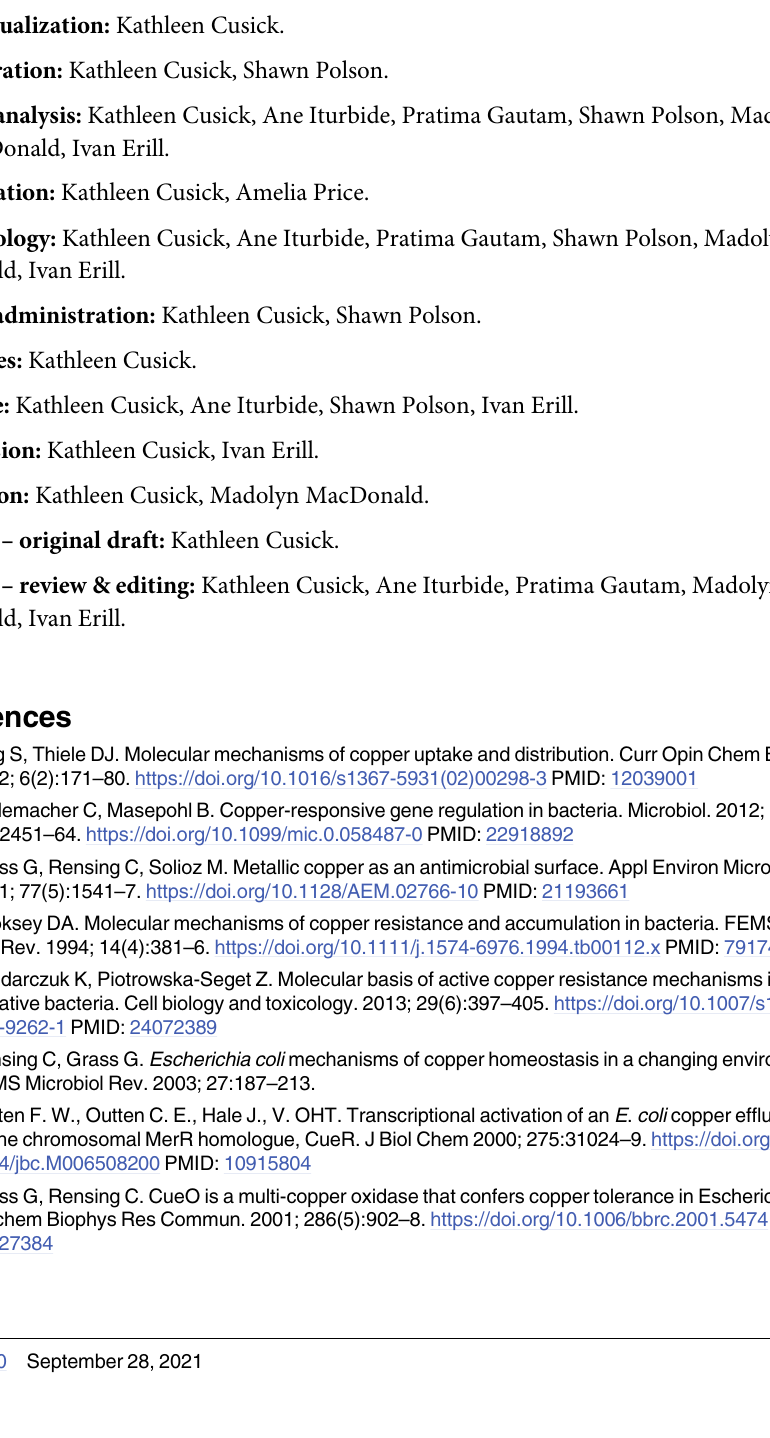
S9 Table. List of genes illustrated on plasmid pCUKW-178.